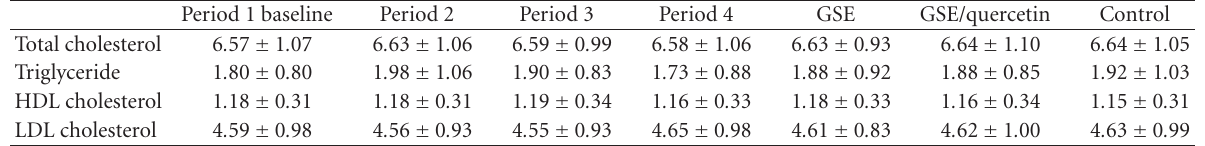
Table 3. E ff ect of GSE and GSE/quercetin on serum lipids mean (mmol/L) ±